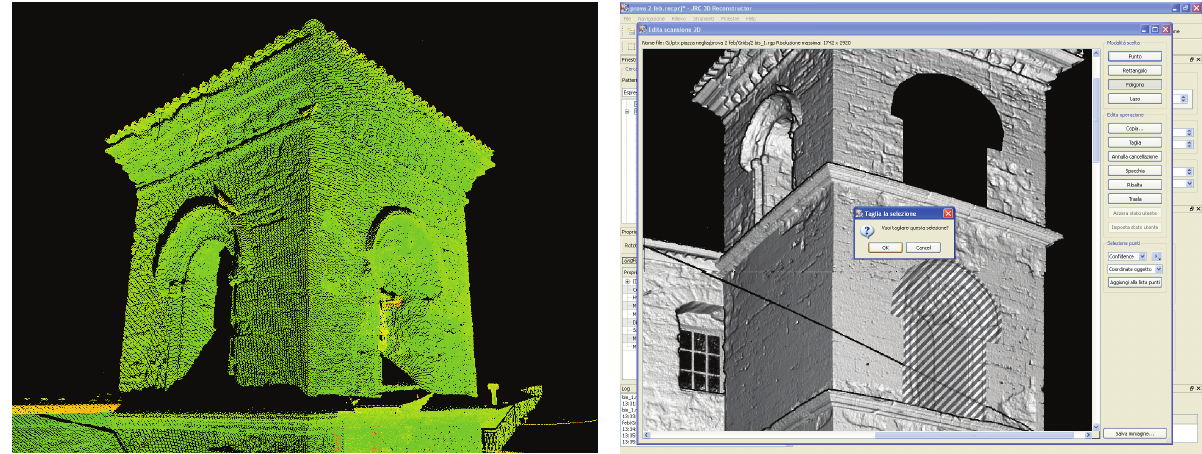
Figure 6. Detailed view of Saint Thomas’ belfry Figure 7. Segmentation into homogeneous portions by “cropping” the original